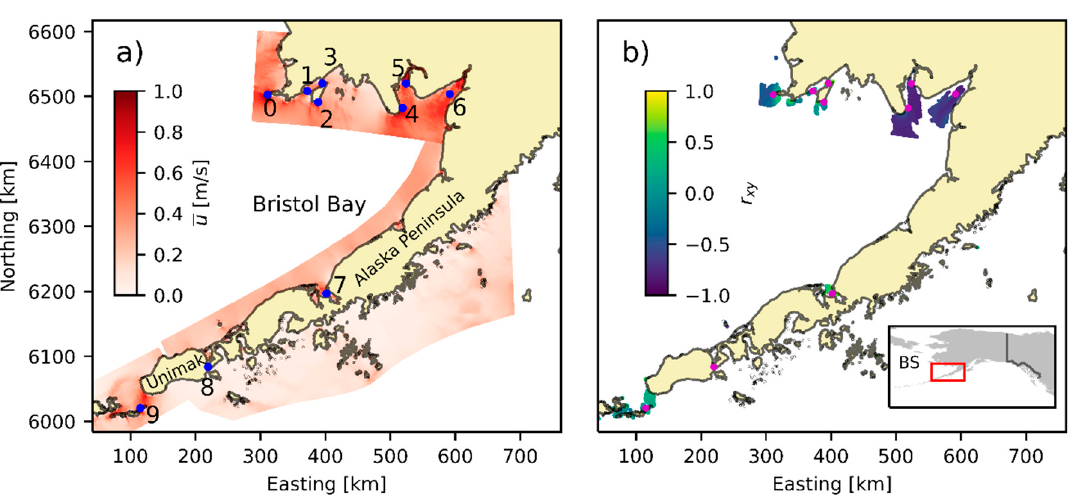
Figure 2. Bristol Bay study area. ( a ) Mean tidal current speed and ( b ) cross-correlation at points with mean velocity above 50 cm / s and deeper than 10 m with respect to the anchor point (0). Representative points for the correlation analysis are identified in both figures. BS stands for Bearing Sea in ( b ).